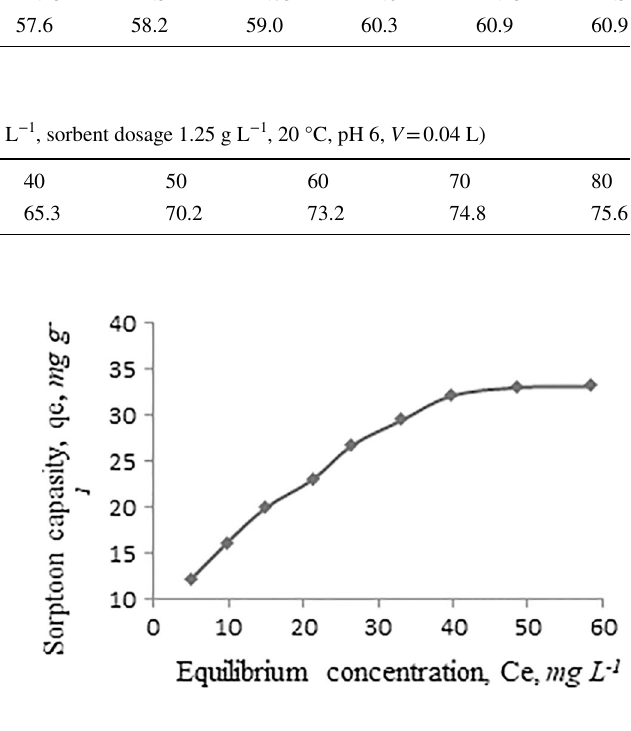
Sorbent dosage (g L −1